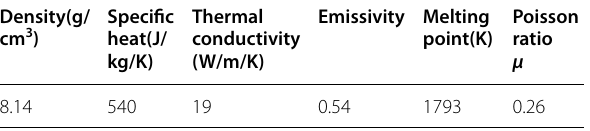
Table 5 Thermal physical parameters of M2 high-speed steel materials